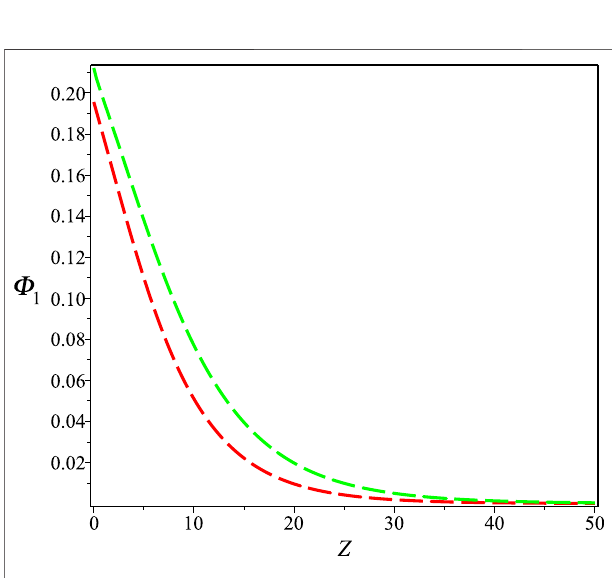
FIGURE 7 | Electrostatic potential with the presence of beta (red color) and RL (green color) fractional derivatives with respect to space and T (cid:2) 10. The remaining parameters are considered as d (cid:2) 1, r (cid:2) e , ρ (cid:2) 0.96, α e (cid:2) 0.5,